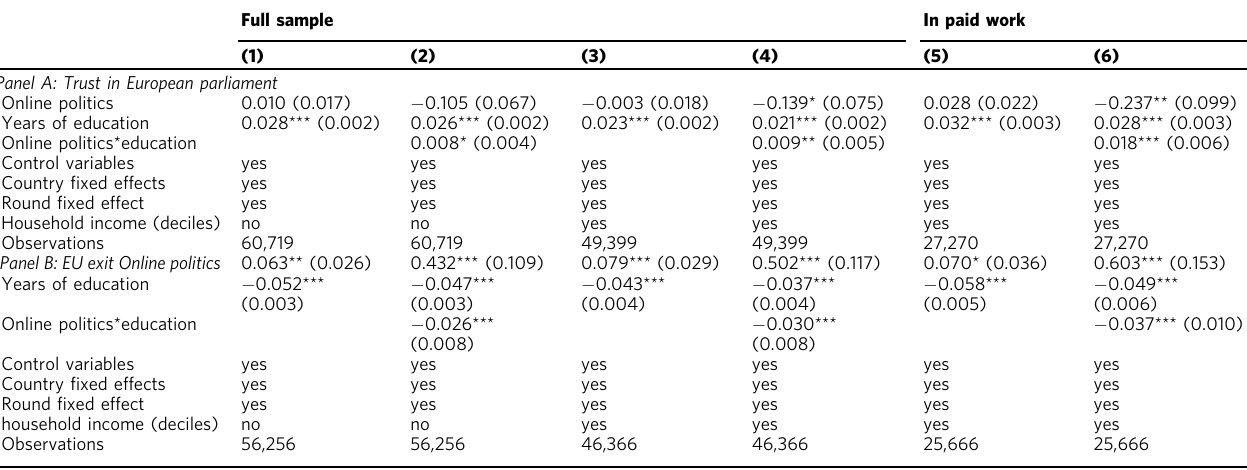
Table 1 Probit regressions of EU exit on online politics interacted with years of education. Full sample In paid